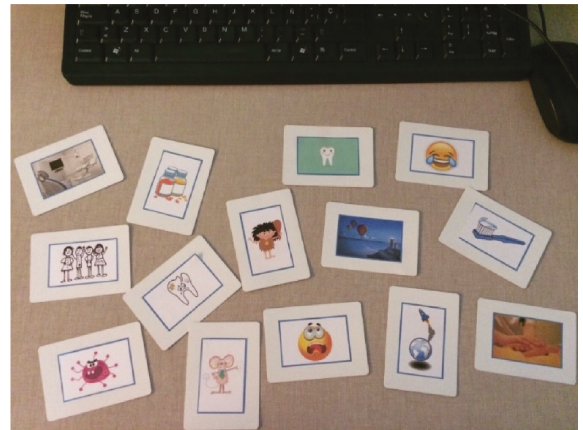
Figure 19: Examples of customized cards used by children to build stories focused on dental issues.